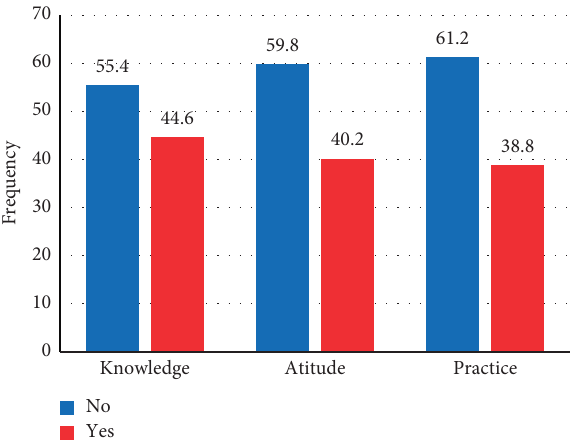
Figure 1: Prevalence of knowledge, attitude, and practice towards YFRHS.